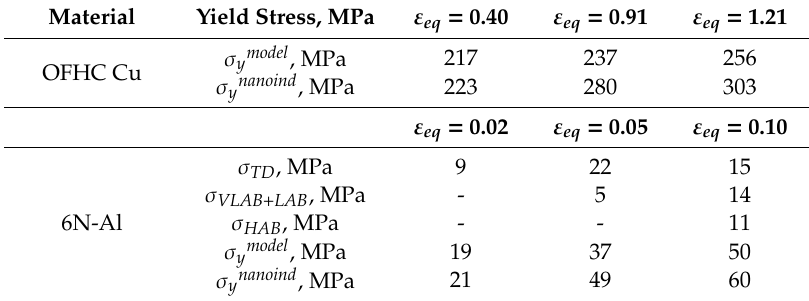
Table 5. Yield stress, σ y , as calculated according to Equation (6) for OFHC Cu, and individual microstructure contributions ( σ TD , σ VLAB + LAB , and σ HAB ) as determined by Equations (13) and (14) for 6N-Al. The yield stress as determined by the nanoindentation hardness measurements, H, using χ = 3.5 as multiplicative factor are reported for comparison. σ ymodel refers to the microstructure model, σ ynanoind refers to the values determined from the nanoindentation